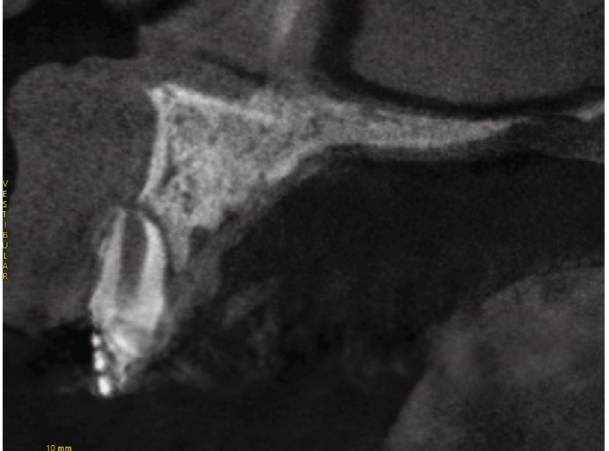
Figure 2: CT scan of tooth 11 area, where it is possible to note external root resorption and extensive resorption of the buccal wall.